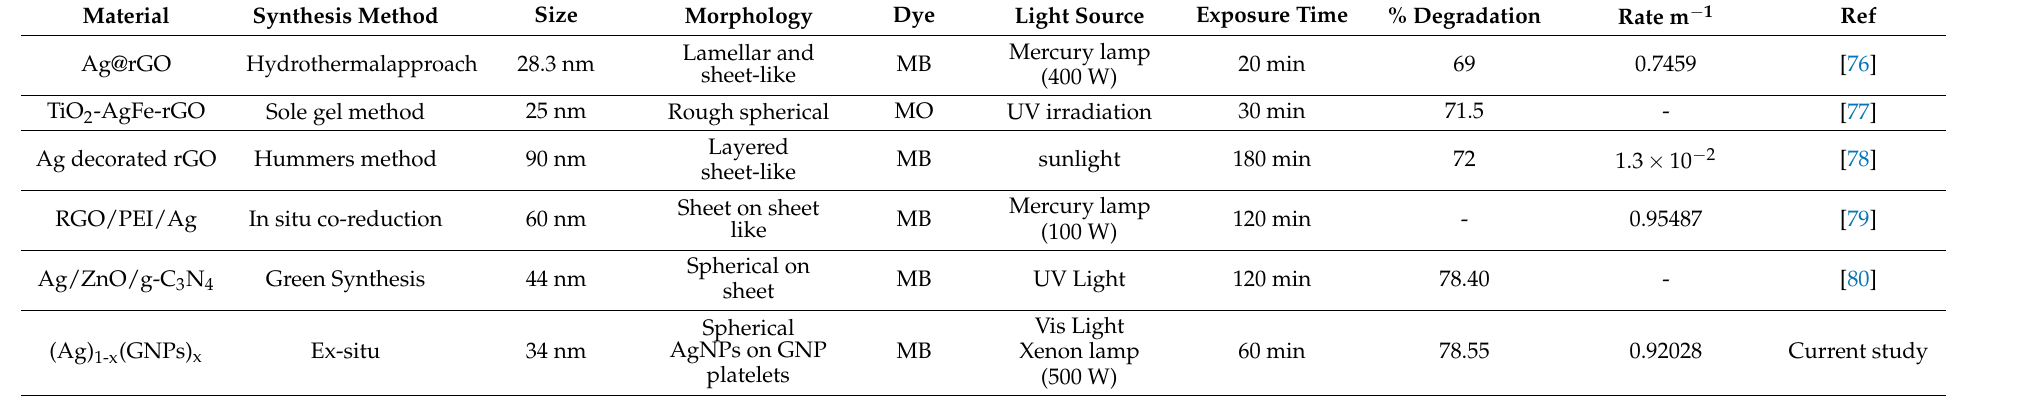
Table 2. Comparative analysis between photocatalytic degradation of different Ag–graphene-based nanostructures, synthesized by various methods against